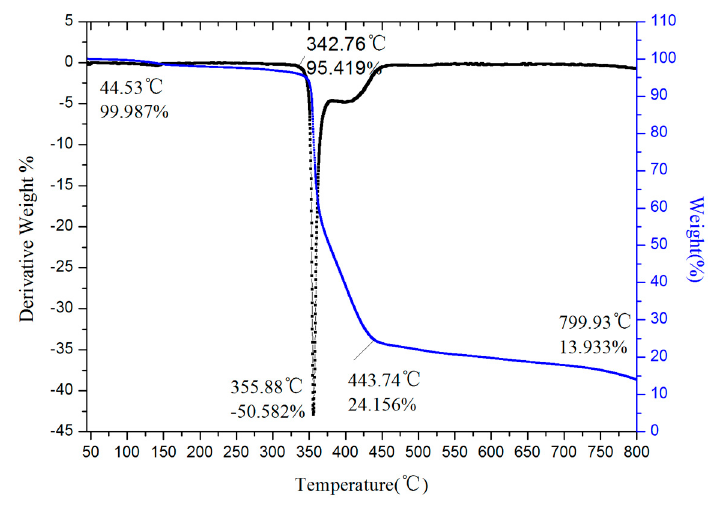
Figure 11. Thermal studies of the [ L -Cu 2+ ] complex with the fluorescent chemosensor.